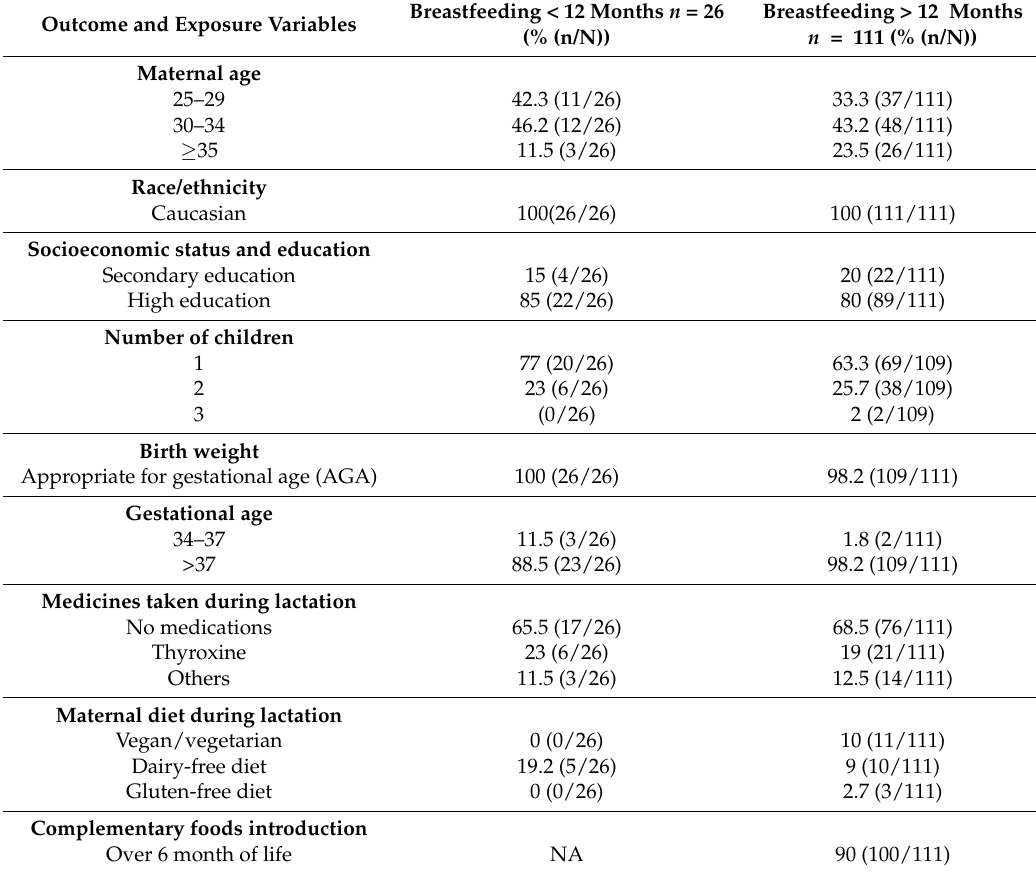
Table 1. Characteristics of the Study